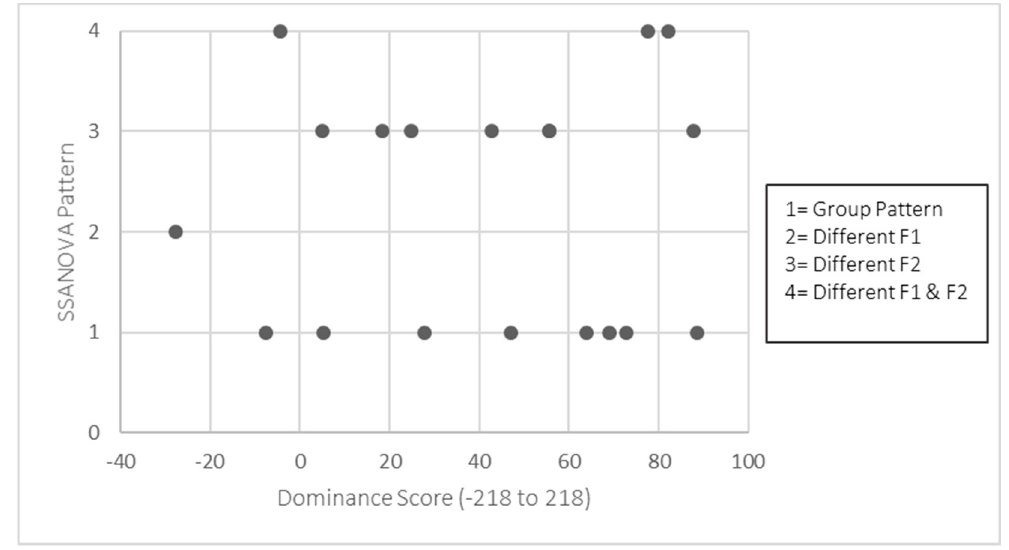
Figure 9. Smoothing Spline pattern type by dominance score.